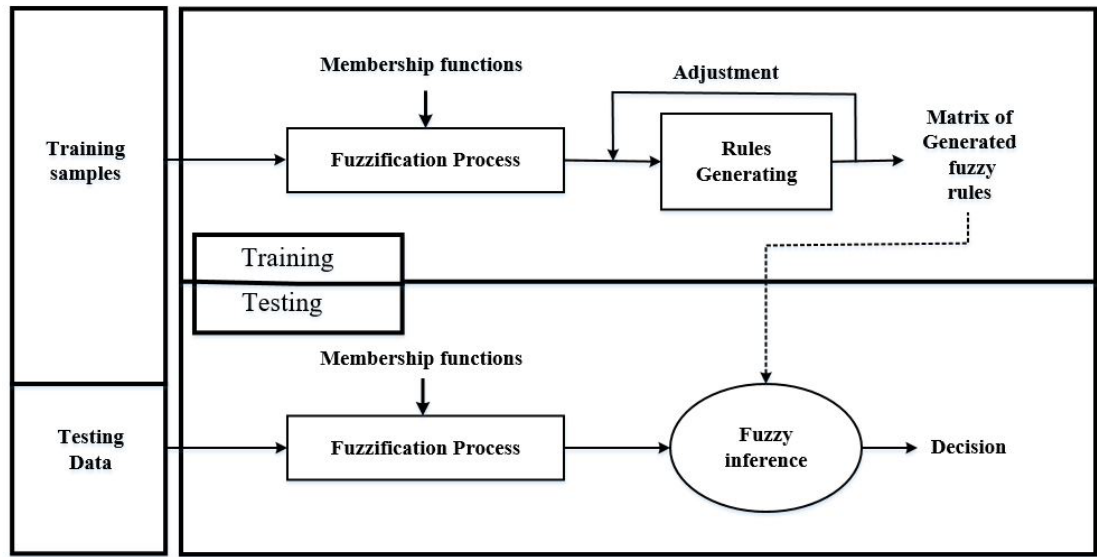
Figure 2. A schematic diagram of the proposed neuro-fuzzy finite state